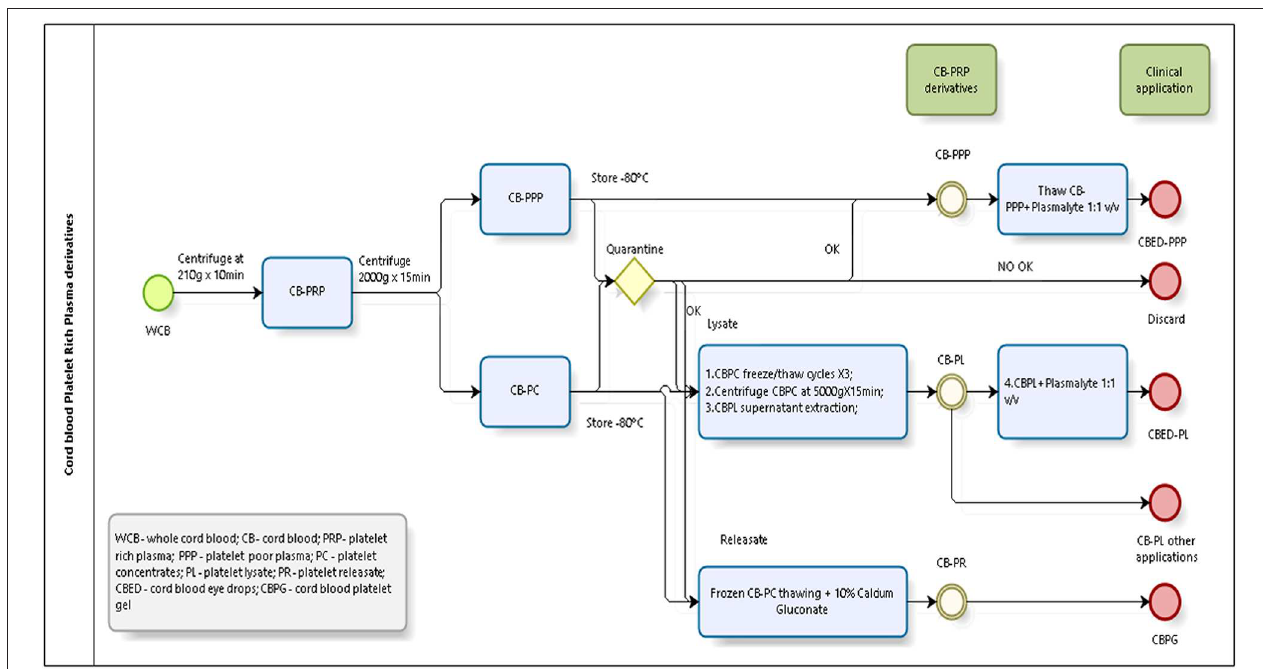
FIGURE 1 | CB-PRP derivatives processing